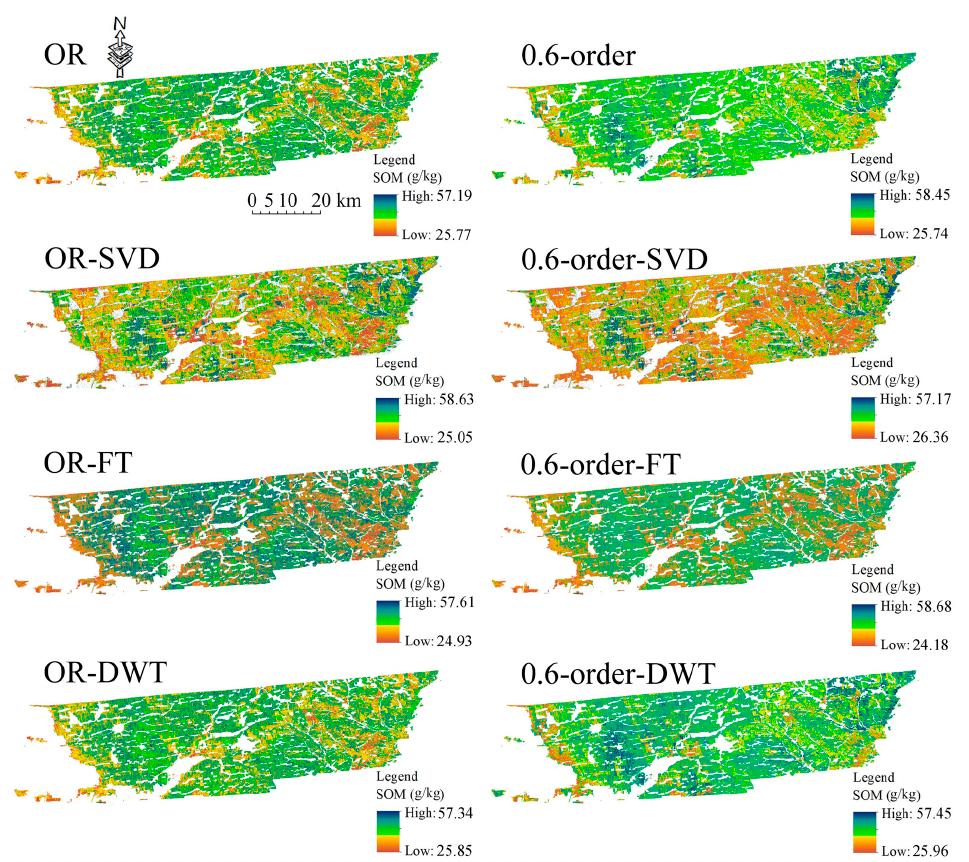
Figure 6. Maps of the SOM spatial distributions under different denoising